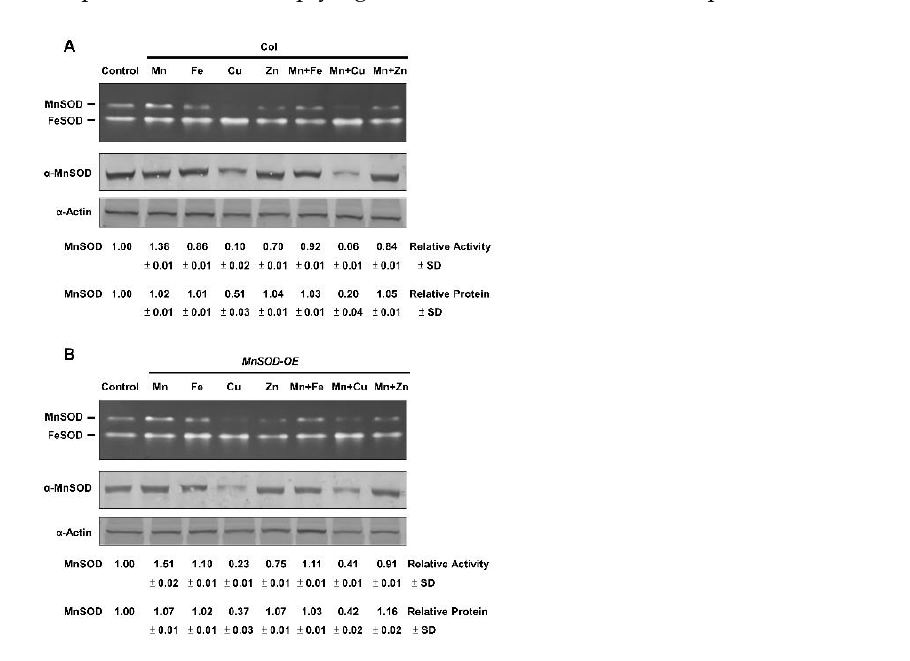
Figure 1. MnSOD activity and protein levels of Col and MnSOD-OE plants in response to Mn, Fe, and duplex metal ion treatments. ( A , B ) Fourteen-day-old seedlings were treated with 1 mM of Mn, Fe, Cu, Zn, Mn and Fe, Mn and Cu, or Mn and Zn for 16 h. In-gel SOD activity assay ( top ) and immunoblotting with α -MnSOD and α -Actin antibodies ( bottom ) were conducted. Actin was used as a loading control. MnSOD activity and protein levels were measured relative to those in control. Data represent one of three independent